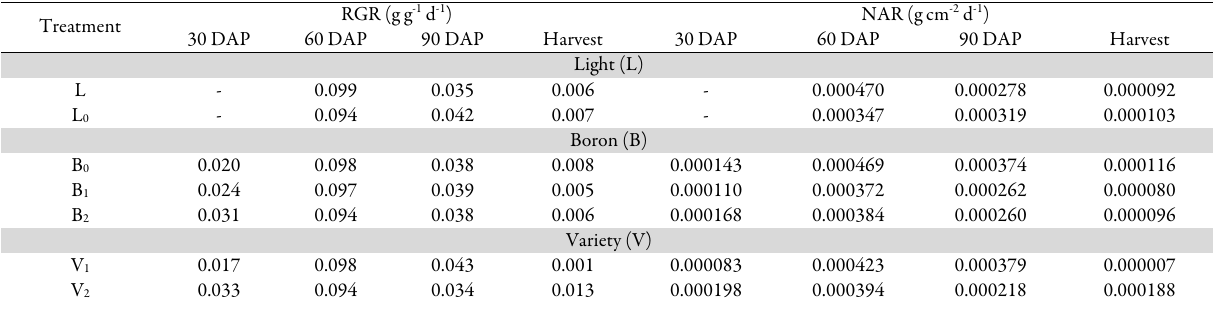
Table 5. Effect of light and boron on relative growth rate and net assimilation rate of two groundnut varieties (mean of two trails)